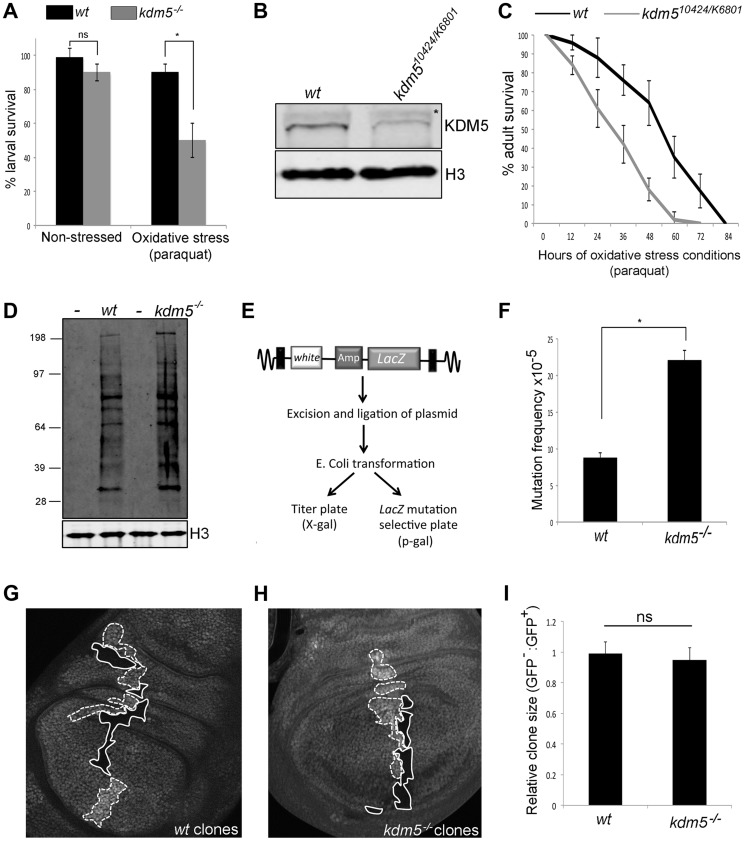
Reducing KDM5 affects cellular levels of oxidative stress.(A) Survival of wildtype control (w1118) and kdm510424/K06801 female larvae in 5% sucrose (left) or in 20 mM paraquat/5% sucrose (right) for six hours. * p<0.01. (B) Western blot showing levels of KDM5 and the loading control histone H3 in wildtype (w1118) and kdm510424/K6801 adult female heads (three heads per lane). (C) Survival curve of w1118 and kdm510424/K06801 adult females fed 20 mM paraquat in 5% sucrose. Adults were one to three days old at the start of the experiment. Error bars represent standard error. The two survival curves are significantly different from one another (p<0.05). (D) Detection of oxidized proteins in wildtype and kdm5K6801 homozygous mutant 3rd instar larvae using oxyblot. Molecular weight markers are shown on the left. – indicates negative control lanes in which carbonyl groups were not derivatized. kdm5 mutants show ∼2-fold increase in total levels of oxidized proteins. Histone H3 is shown as a loading control. (E) Schematic of lacZ mutation reporter assay. Adapted from Garcia et al [51]. (F) lacZ mutation frequency of wildtype control (w1118) and kdm510424 homozygous mutant 3rd instar larvae. Genotypes are w1118; #9lacZ; + (labeled wt) and w1118; kdm510424, #9lacZ; + (labeled kdm5−/−. * p<0.01. (G) Generation of wildtype clones in a wildtype background in larval wing imaginal disc. Genotype is hs-FLP122/+; FRT40A/FRT40A ubi-GFP. Areas circled with dashed line have two copies of ubi-GFP (twin spots). Areas shown with a solid line have no GFP. (H) Generation of kdm5K6801 mutant clones in wing imaginal disc. Genotype is hs-FLP122/+; kdm5K6801 FRT40A/FRT40A ubi-GFP. Areas shown with a dashed line have two copies of GFP (twin spots). Areas circled with sold line are homozygous mutant for kdm5K6801. (I) Quantitation of clone area in E (wt; N = 6) and F (kdm5 mutant; N = 8). ns = not significantly different.